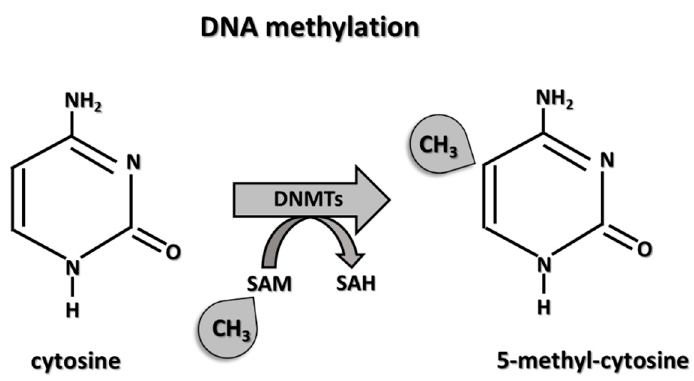
Figure 1. The mechanism of DNA methylation. DNA methylation is exerted by DNA methyltransferases (DNMTs). DNMTs at the 5 ′ -position of cytosine residues in CpG dinucleotides transfers methyl groups from SAM (S-adenosylmethionine) to SAH (S-adenosylhomocysteine); thus, 5-methylcytosine is formed.